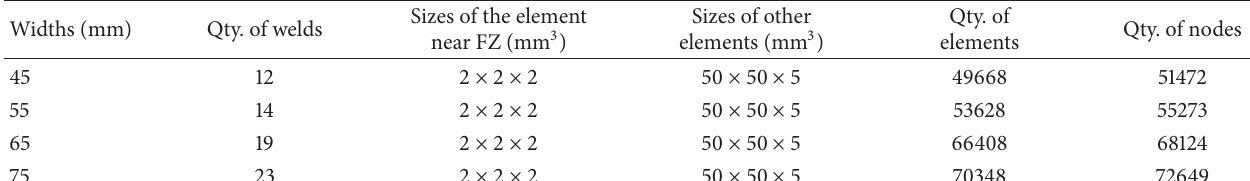
Table 3: Element sizes.